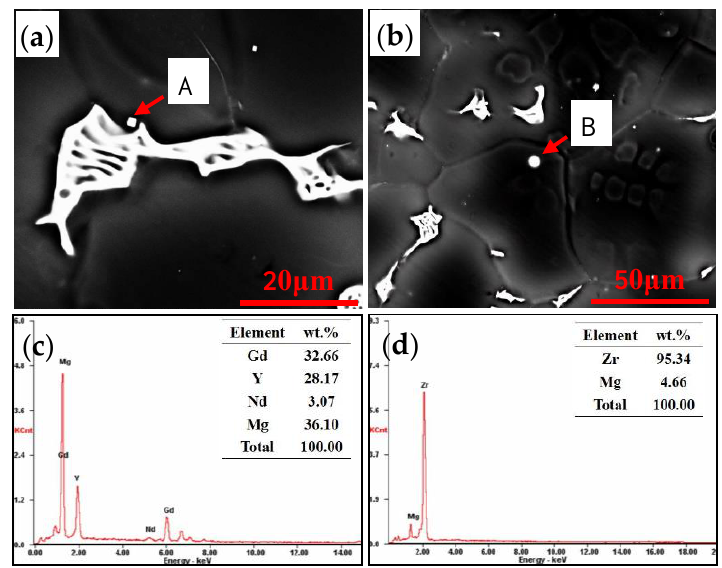
Figure 3. Partial region feature of alloy C in as-cast condition: ( a ) The area containing block shaped particles. ( b ) The area containing spherical particles.( c ) EDS results of particle A. ( d ) EDS results of particle B.